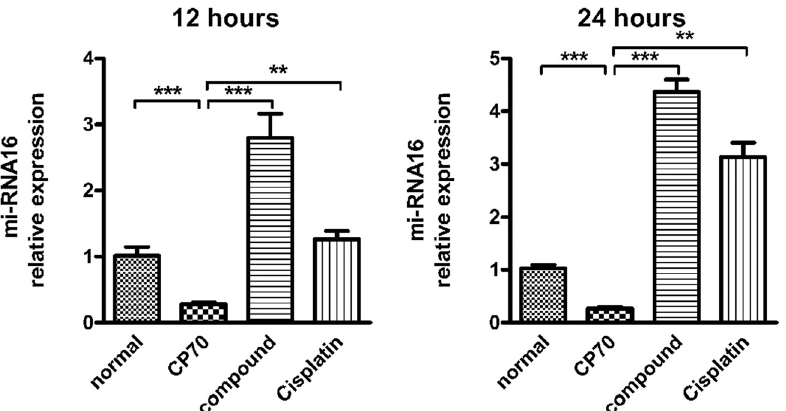
Figure 3: Increased the mi - RNA16 relative expression in the cancer cells of CP70 ovarian after treated by the compound. The CP70 ovarian cancer cells were inoculated into plates of 6 well and carried out compound treatment for half a day and 1 day. The relative expression level of the mi - RNA16 in CP70 ovarian cancer cells was measured with RT - PCR. **means p < 0.01, ***means p <